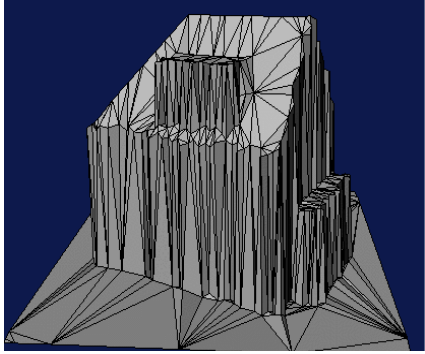
Fig. 7. Further simplification based on segmentation.